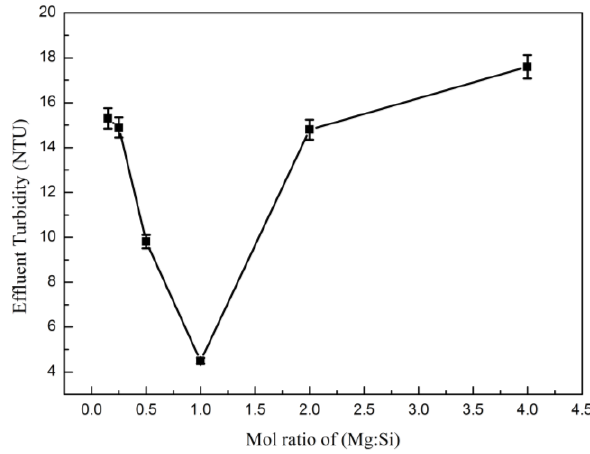
Figure 6. Effect of nMg:nSi on the Mg-PSAFS removal of turbidity.